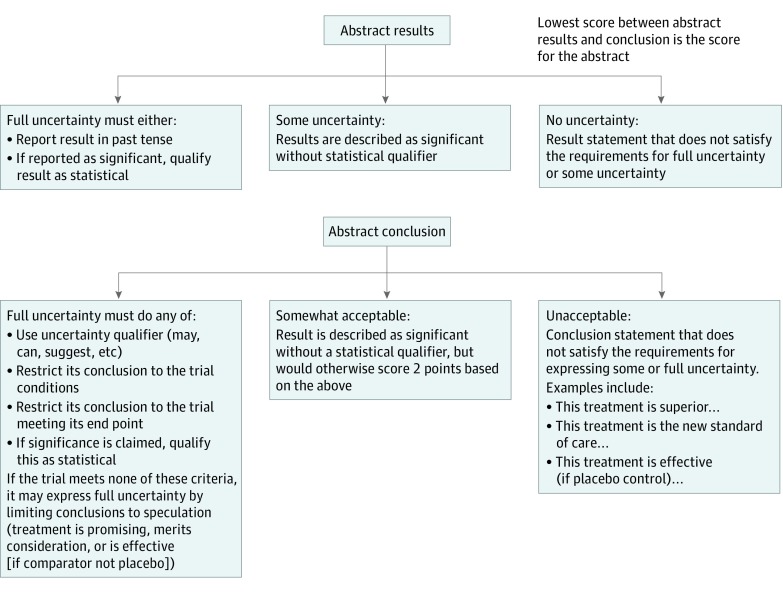
Algorithmic Approach for Evaluation of UncertaintyGraphical representation of the algorithm used to systematically evaluate the abstracts for uncertainty. A rationale is provided in the eAppendix in the Supplement.